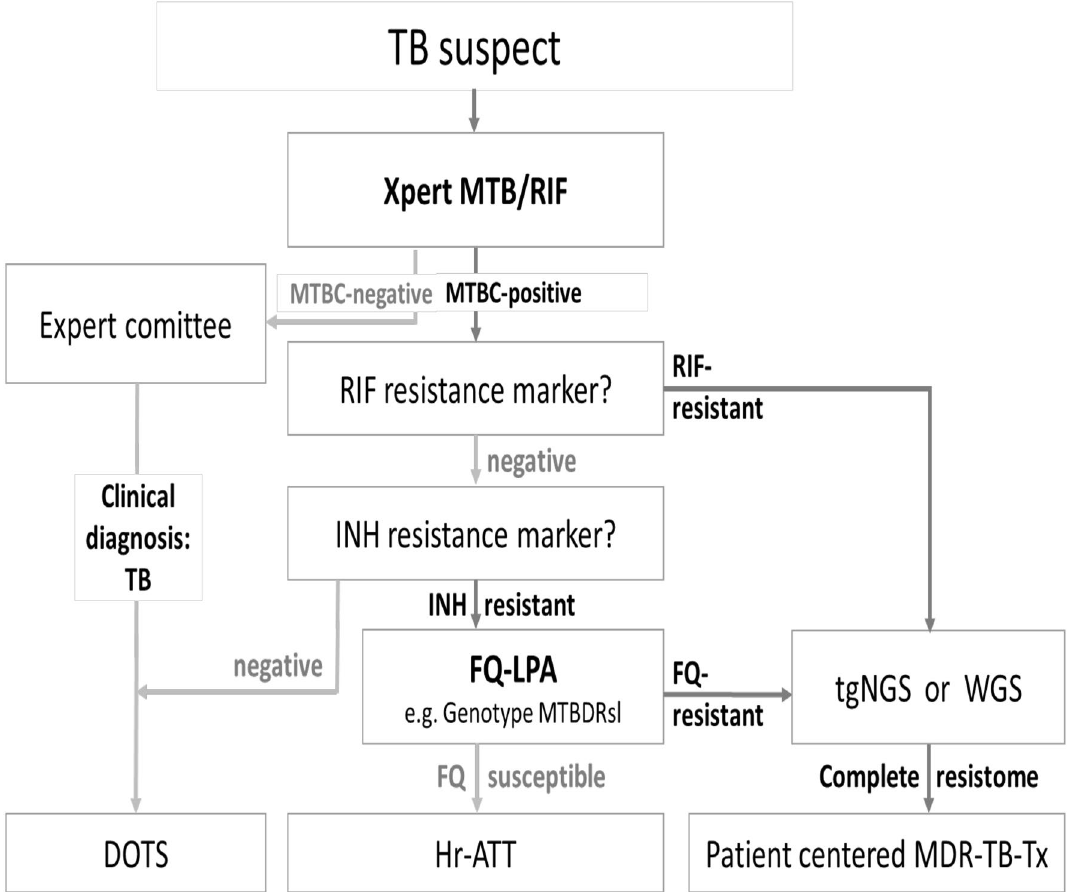
Figure 2. Updated diagnostic algorithm including NGS. In a workshop with national and international TB stakeholders of Kyrgyzstan, the diagnostic algorithm of TB was complemented with NGS as new diagnostic tool. According to this new consensus algorithm, NGS shall be applied to all rifampicin resistant and to all isoniazid and fluoroquinolone poly-drug-resistant cases. RIF rifampicin; INH isoniazid; FQ fluoroquinolone; LPA line probe assay; tgNGS targeted next generation sequencing; WGS whole genome sequencing; DOTS directly observed therapy short course; Hr-ATT anti-tuberculosis therapy for isoniazid resistant TB; Tx